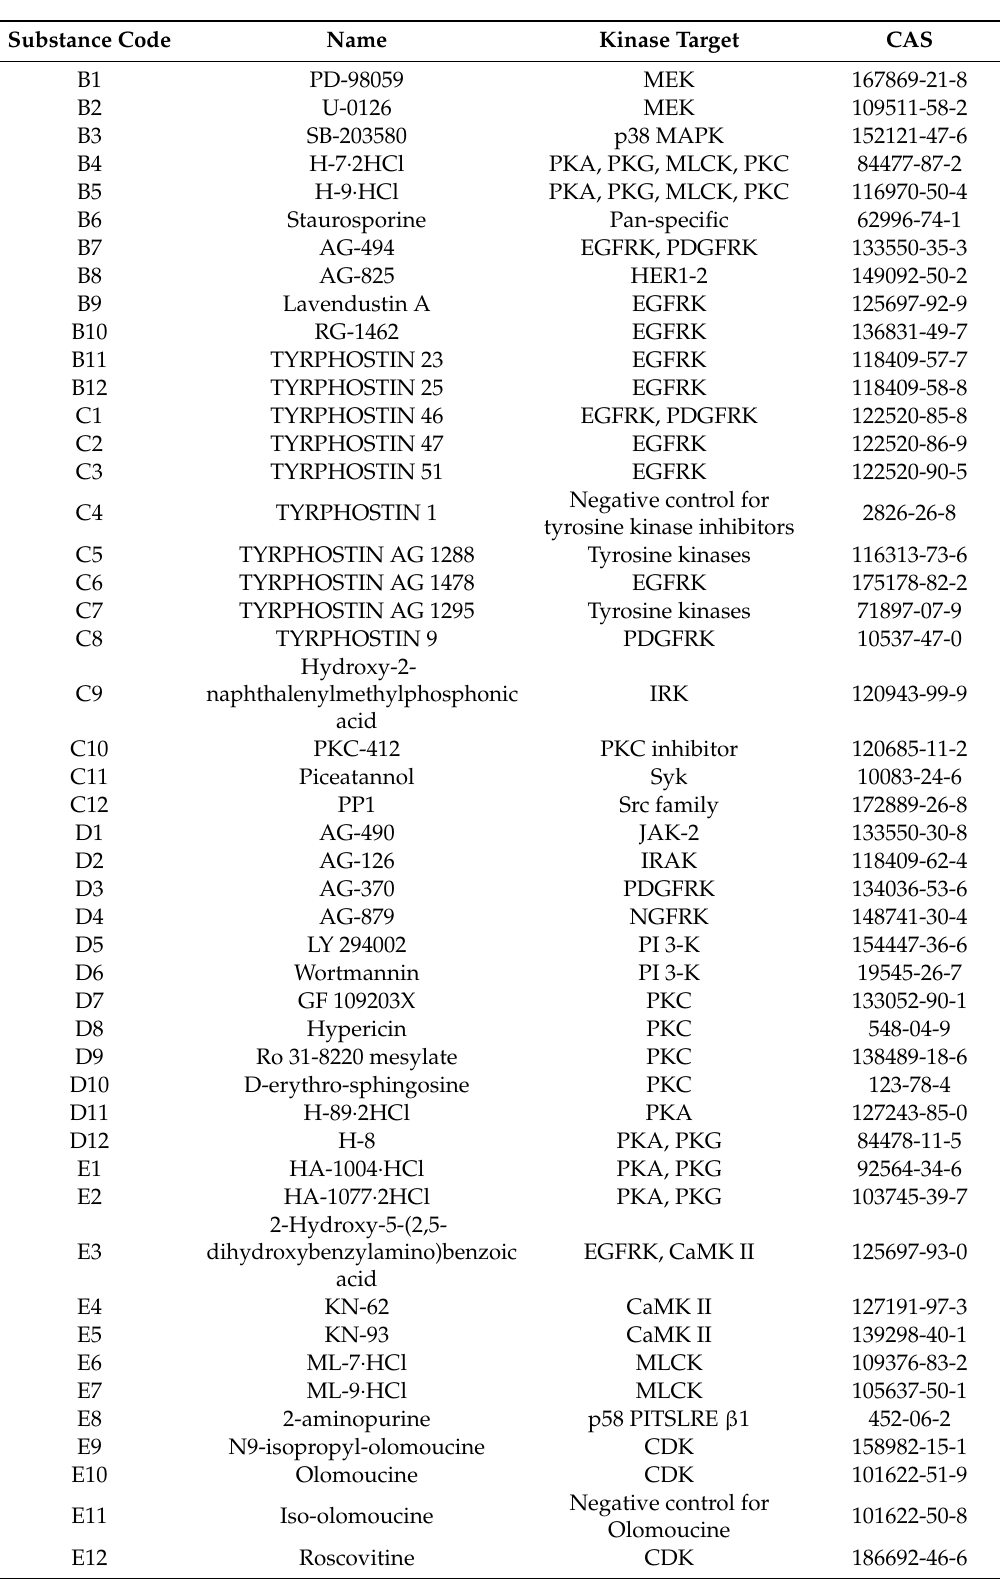
Table 1. Overview of the kinase inhibitors utilized in this study. Listed are all inhibitors used in this study, their substance code used throughout the figures and text, the target structure of the inhibitors, and the CAS